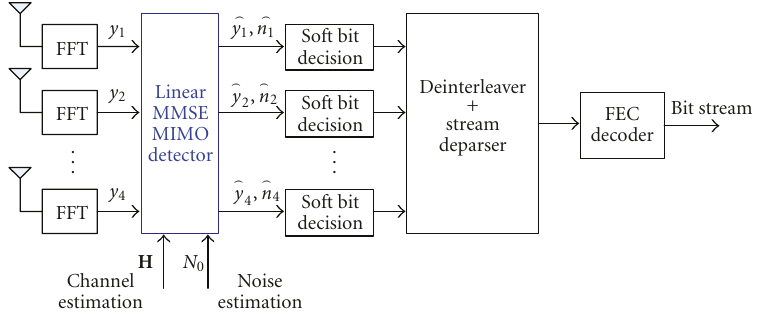
Figure 1: Receiver block diagram.